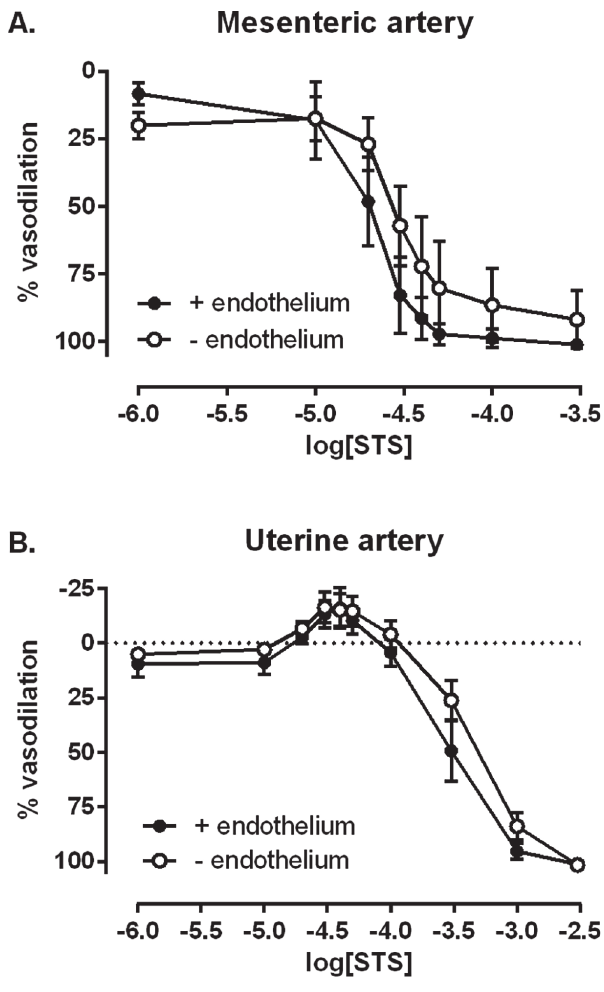
Fig 3. Endothelium-independent responses to STS. Vascular responses to STS in A: mesenteric arteries and B: uterine arteries from the pregnant rat (GD 10.9 ± 0.2) with intact endothelium (closed circles) or following endothelial removal using a knotted human hair (open circles). Mesenteric intact n = 6; mesenteric denuded n = 5; uterine intact n = 4; uterine denuded n =